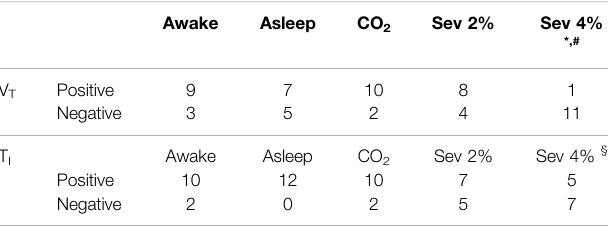
TABLE 1 | Number of data series of tidal volume (V T ) and inspiratory time (T I ) with positive or negative autocorrelation coef fi cients at lag one breath. (Sev: sevo fl urane).